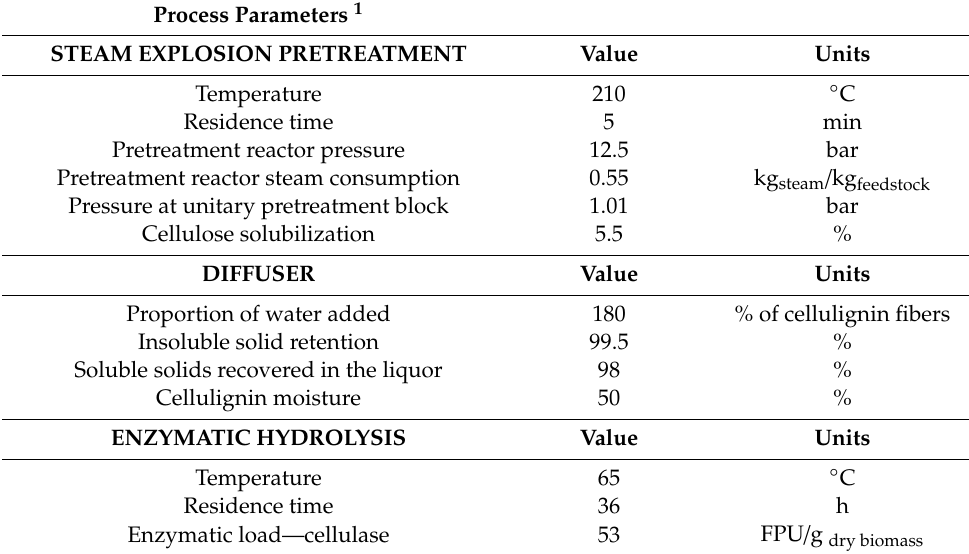
Table A7. Main technical parameters adopted in the simulation of the second-generation (2G) ethanol